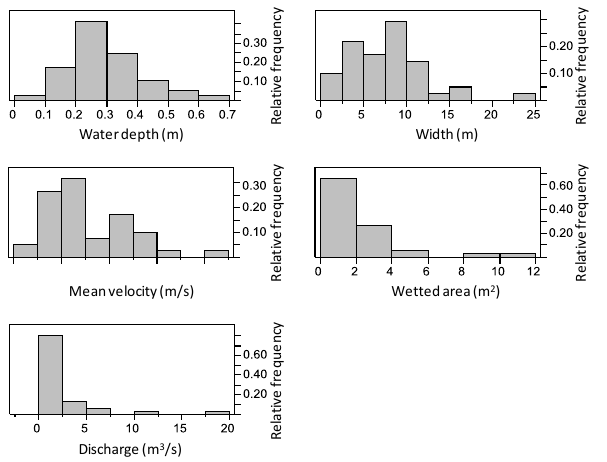
Figure 5. Distribution of the AFIG hydraulic characteristics Fig. 5. Distribution of the AFIG hydraulic characteristics.